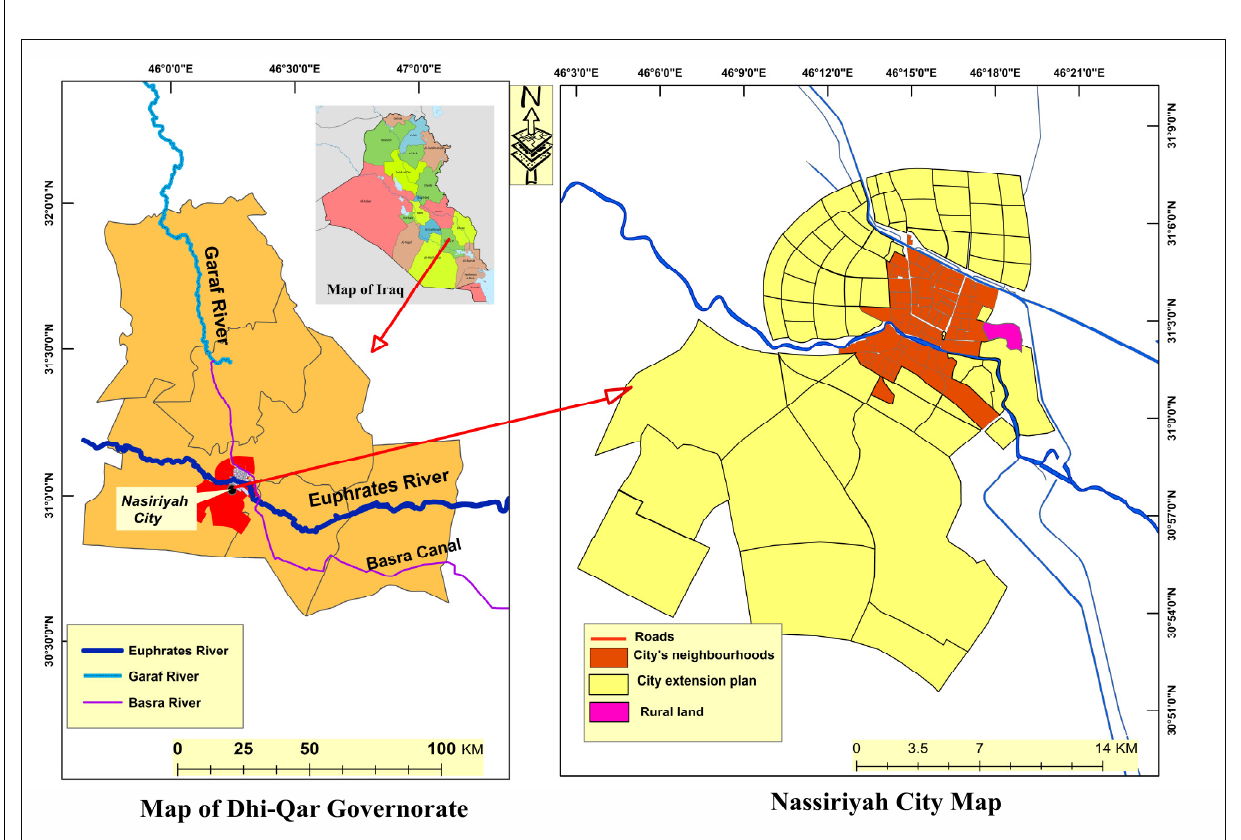
Figure 1. The study area: Nasiriyah city, Iraq.